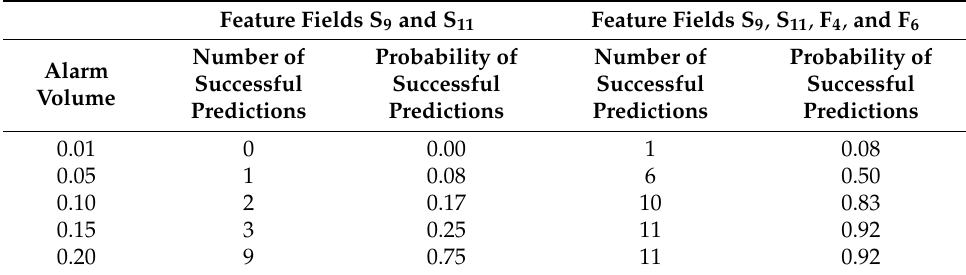
Table 8. California. Probabilities of earthquake prediction with magnitudes m ≥ 5.5 from seismologi- cal fields and from the same fields together with GPS fields.